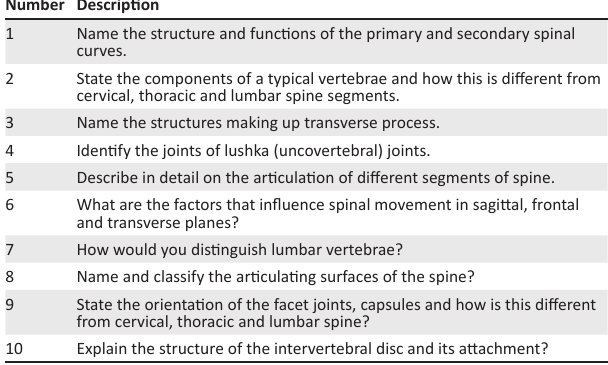
TABLE 2: The learning objectives in task 1 were focused on understanding the relationship between normal structure and functions of spine in both traditional and Augmented Reality teaching